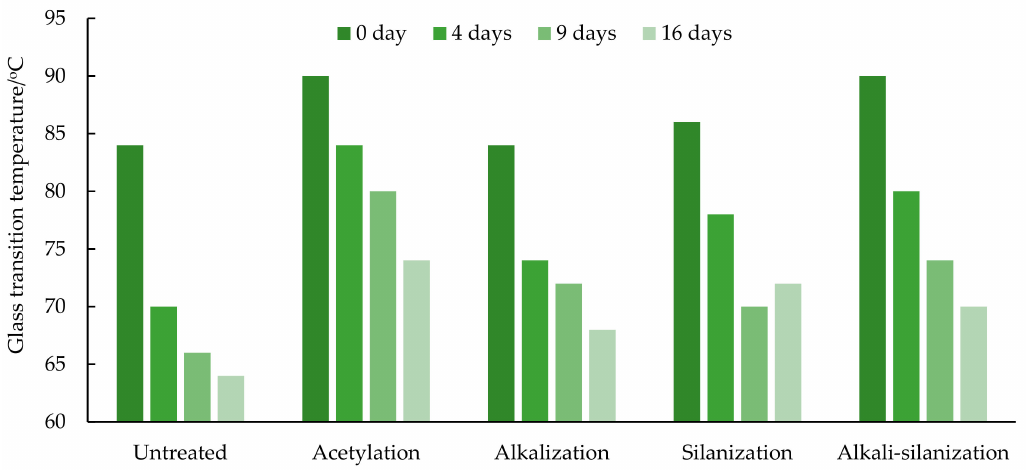
Figure 6. Glass transition temperature of